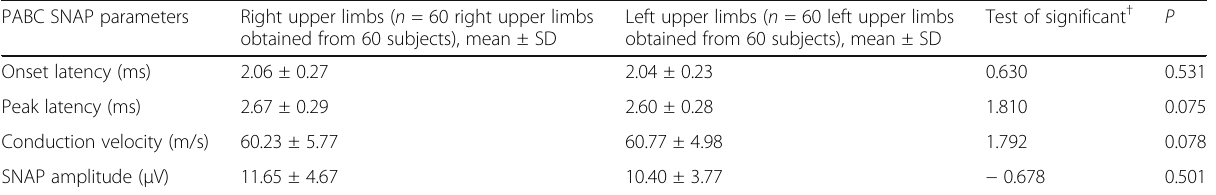
Table 3 Comparison between right upper limbs versus left upper limbs regarding different posterior antebrachial cutaneous sensory nerve action potential parameters